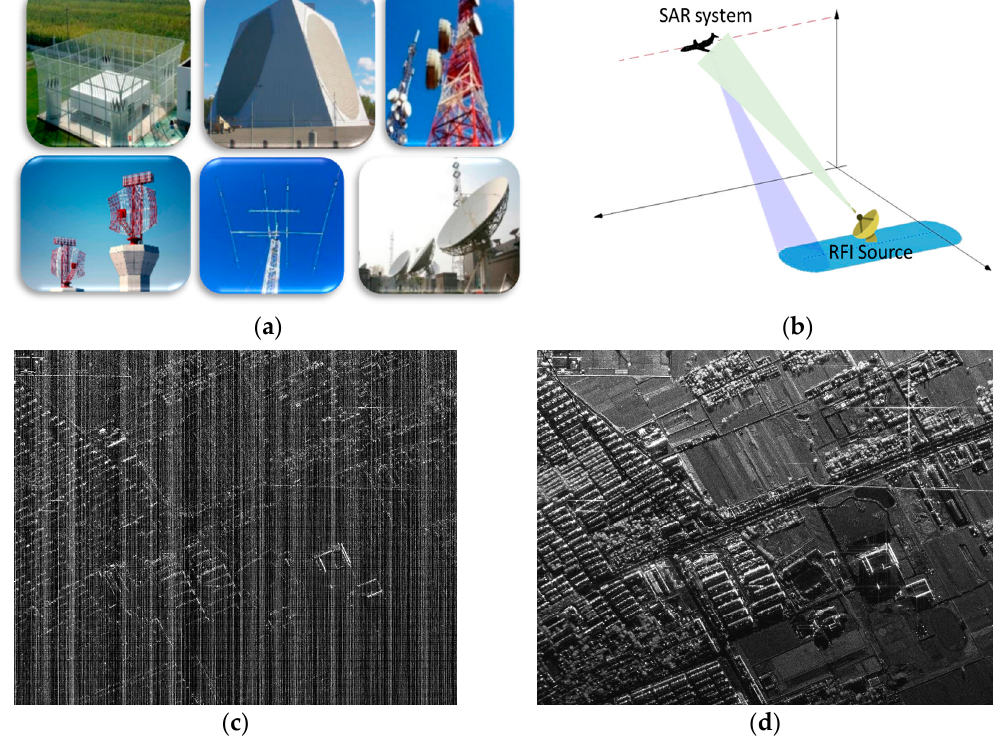
Figure 6. Illustration of the terrestrial RFI case. ( a ) Possible terrestrial radio emitters. ( b ) Interfering geometry of terrestrial RFI. ( c ) SAR image contaminated by RFI and ( d ) without presence of RFI.